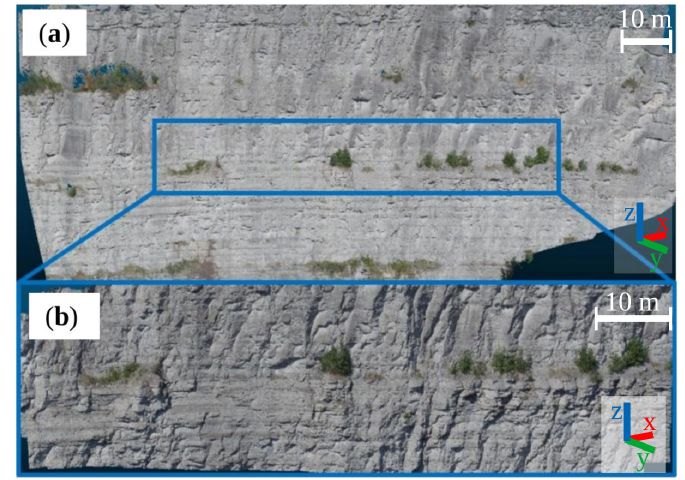
Figure 18. 3D point cloud of Mine B using ( a ) a 15 mm lens and ( b ) a 45 mm